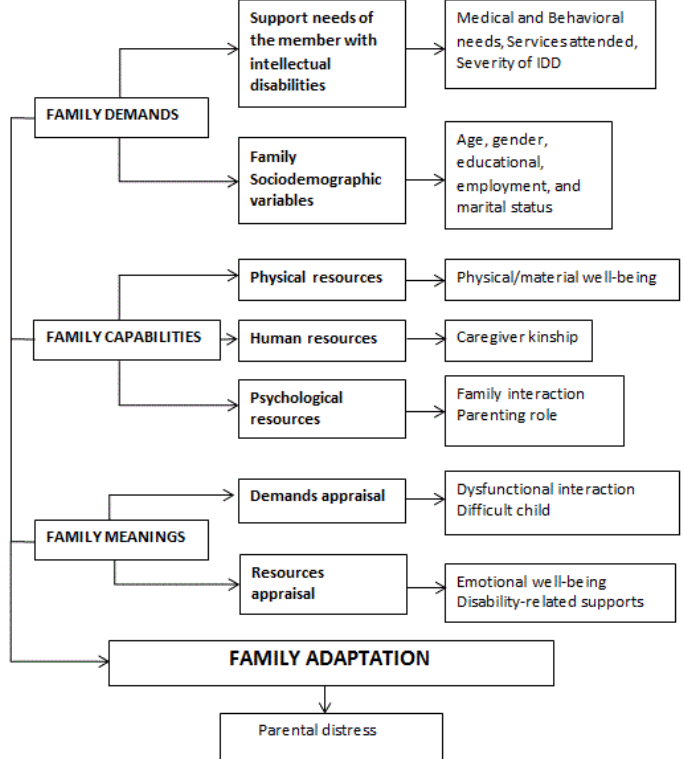
Figure 1. Relevant variables in the process of family adaptation to the care of a relative with a disability. IDD = Intellectual and Developmental Disabilities.